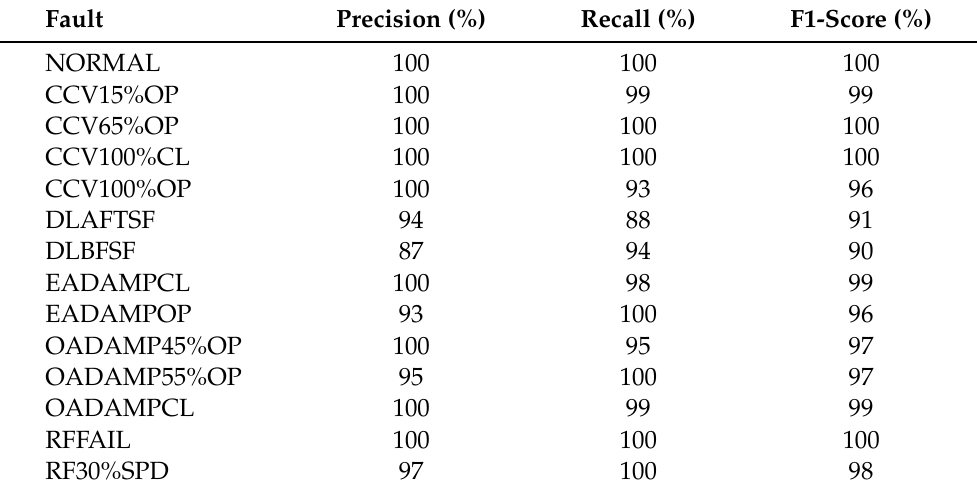
Table 2. Classification report for proposed